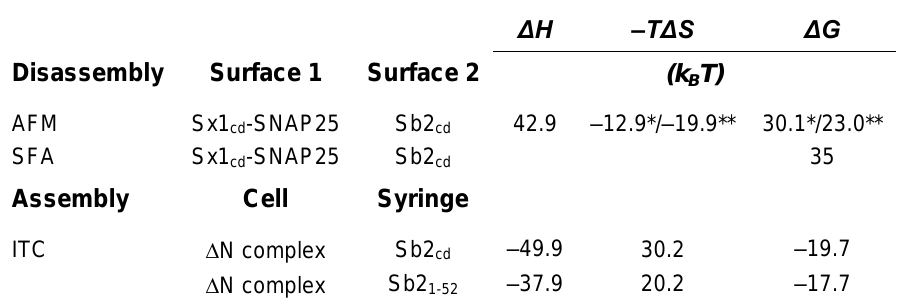
Energetics of (Dis)assembly of the Ternary SNARE Complex